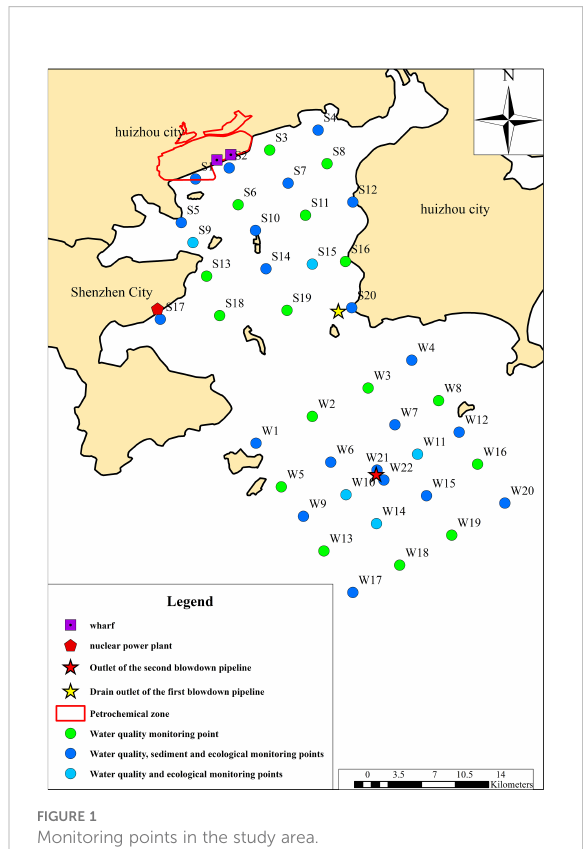
FIGURE 1 Monitoring points in the study